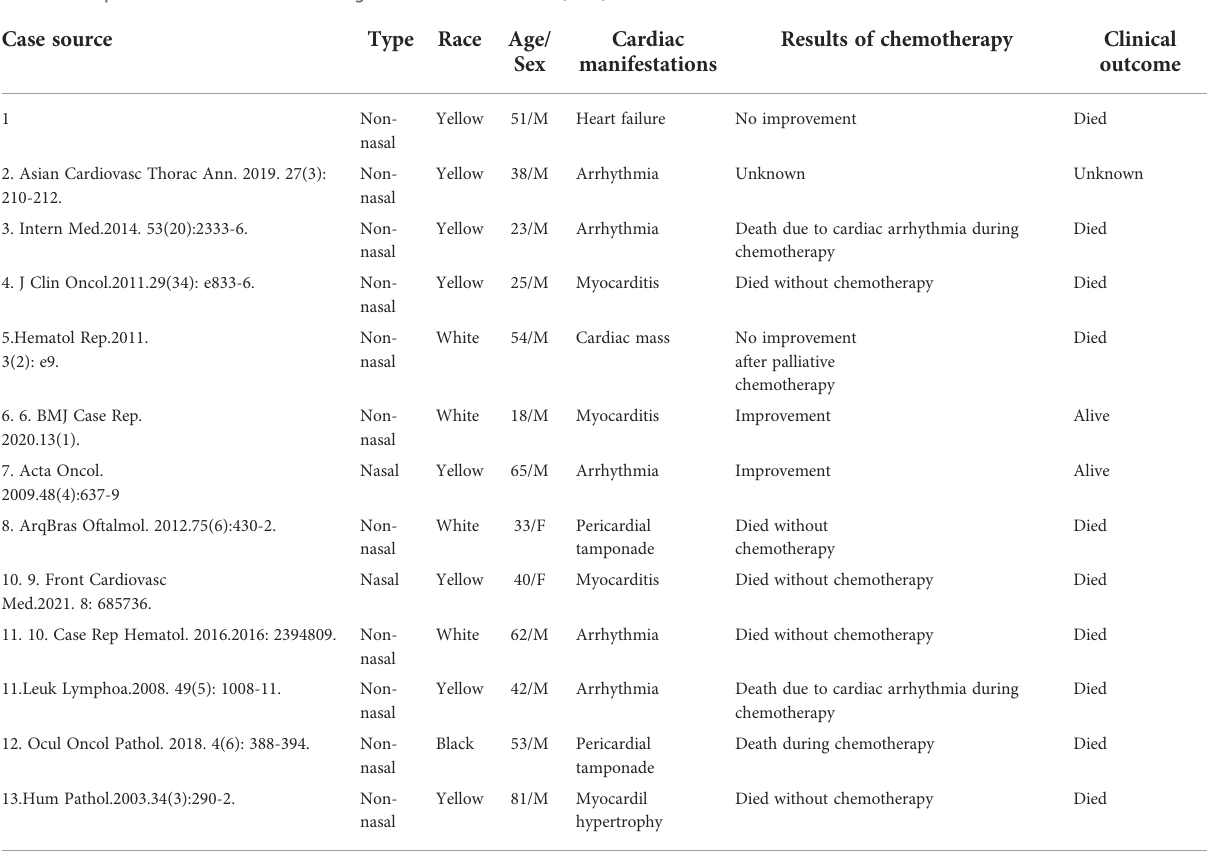
TABLE 2 Reported cases of ENKTL invading the heart and our case (1-12).